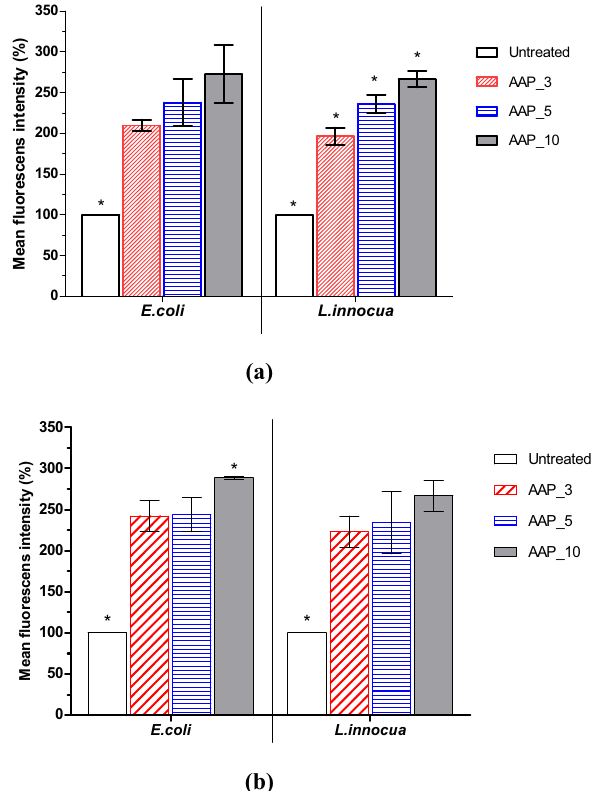
Figure 2. Intracellular levels of RONS in E. coli and L. innocua 96 h biofilm cells after atmospheric air plasma treatment ( a ) ROS ( b ) RNS levels. Data are the mean percentage values of fluorescence intensity. Results represent the average of two independent experiments, each one performed in triplicate (n = 6). Statistical analysis and graphs were generated using GraphPad Prism version 5.0 (GraphPad Software, San Diego, California USA, http://www.graph pad.com). Separate one-way ANOVA tests were performed for each biofilm forming species to make a comparison between the untreated control and the different atmospheric air plasma treatments. Asterisk indicates significance difference (p ≤ 0.05). AAU_15: airborne acoustic ultrasound treatment for 15 min; AAU_30: airborne acoustic ultrasound treatment for 30 min; AAP_3: atmospheric air plasma treatment for 3 min; AAP_5: atmospheric air plasma treatment for 5 min; AAP_10: atmospheric air plasma treatment for 10